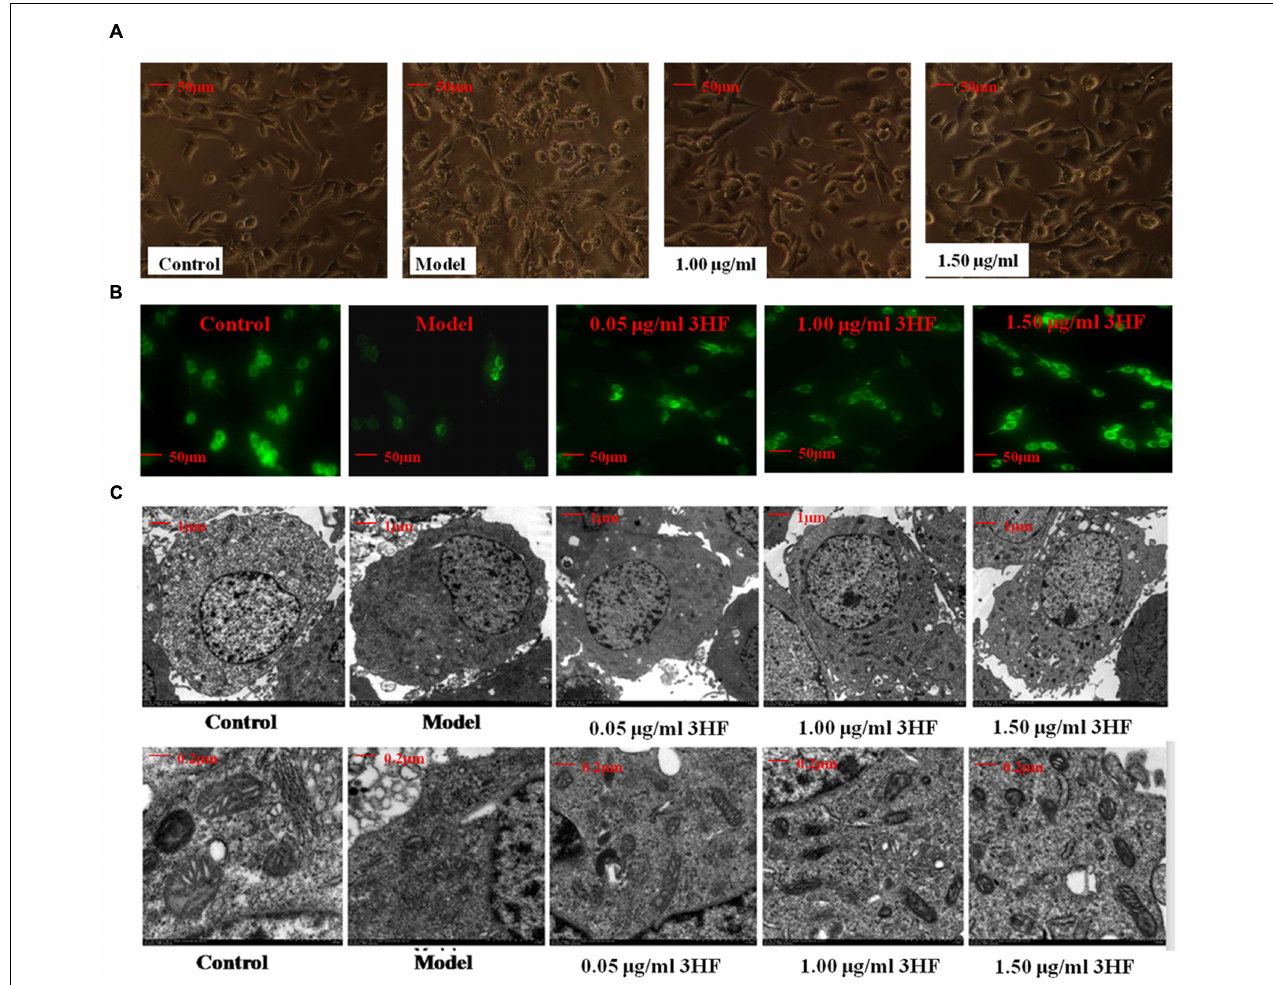
FIGURE 6 | Effect of 3HF on the cellular and mitochondrial morphology. (A) The investigation was conducted by inverted microscope; (B) The investigation was conducted by fluorescent microscope at the wavelength of 490 nm. The number of cells and fluorescence intensity of the model group (treated with 0.03 mM NaN 3 for 24 h) were lower compared with the control, while the 3HF increased the number of cells and fluorescence intensity; (C) The analysis was carried out by electron microscopy (1 and 5K). The 0.03 mM NaN 3 treated groups indicated an ultrastructural change with disappearance of the nucleolus, condensed chromatin that was localized to the inner side of an intact nuclear membrane, blur mitochondria with disintegration and substantial lysis of cristae in PC12